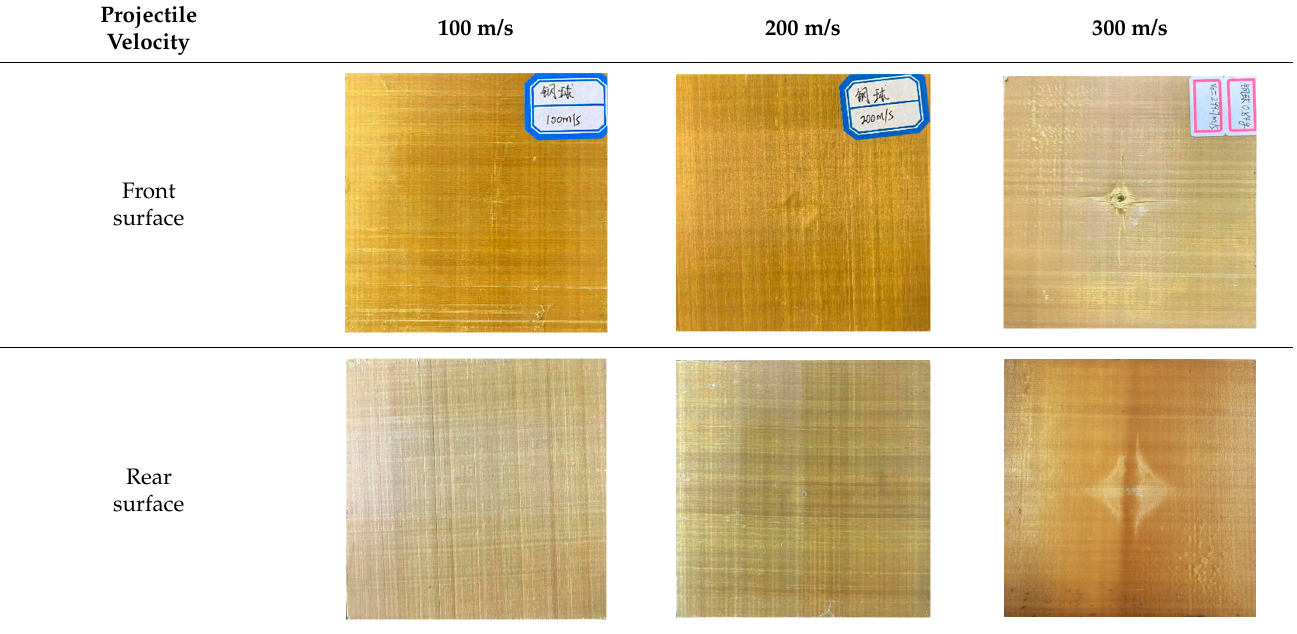
Table 1. The damage to Kevlar49/epoxy composite laminates under ballistic impact.